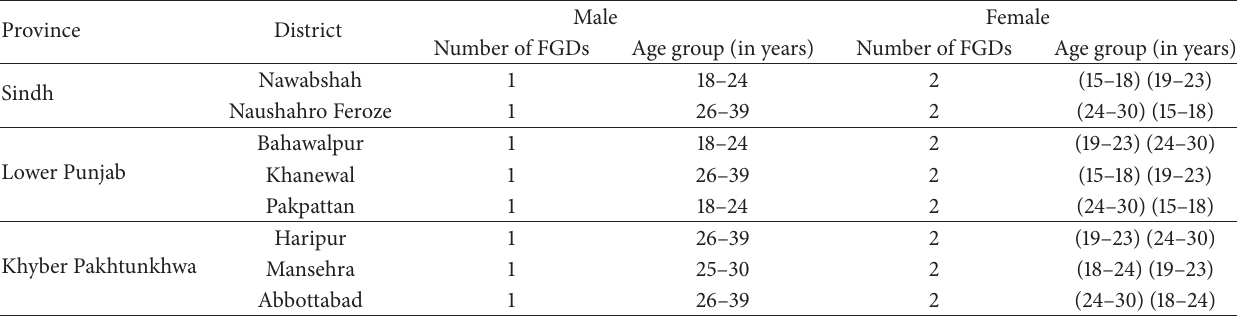
Table 1: Area- and participant-wise data collection details of the study participants.